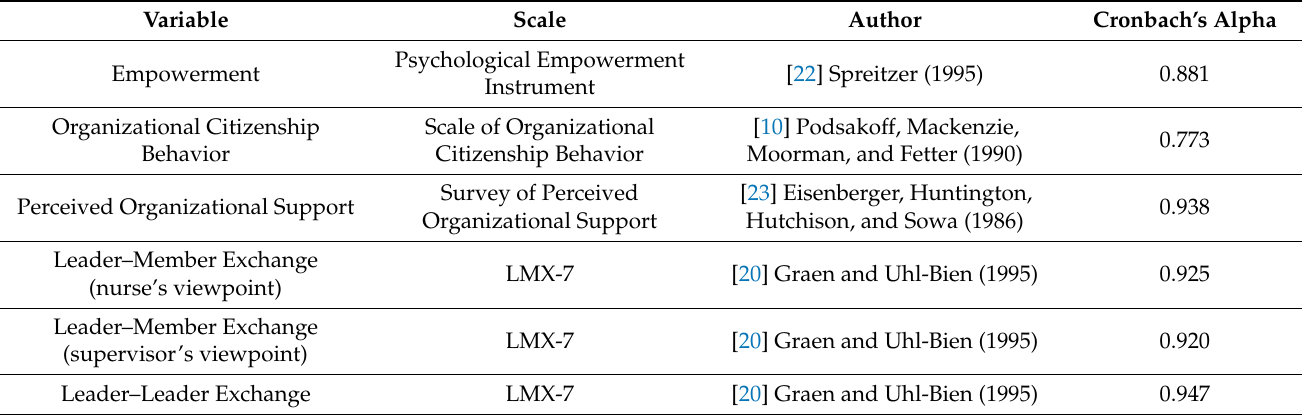
Table 1. Summary of scales used in this